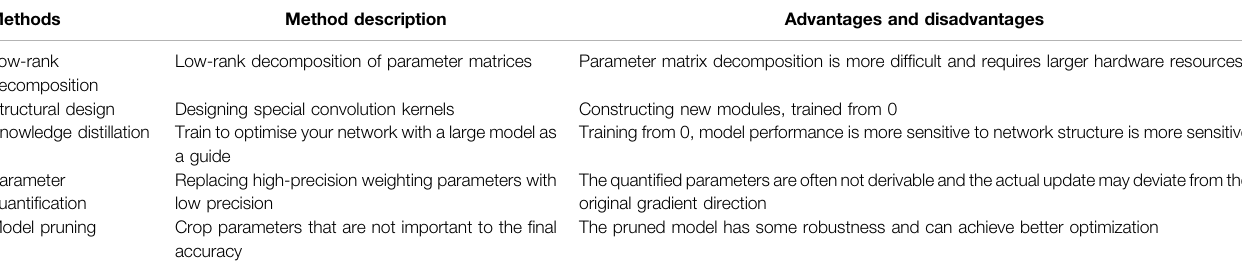
TABLE 1 | Model compression